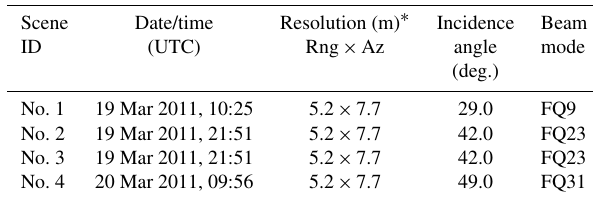
Table 3. Specifications of the qual-pol RADARSAT-2 SAR